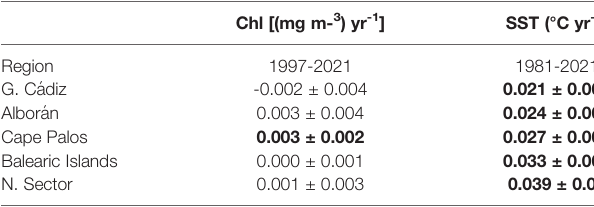
Bold numbers indicate those results that are statistically signi fi cant.